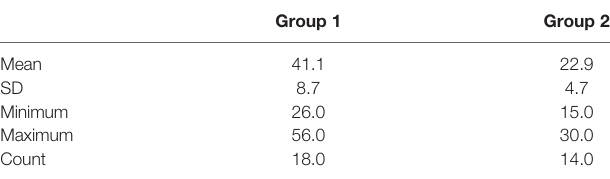
TABLE 2 | The procedure durations of both groups of patients (min).